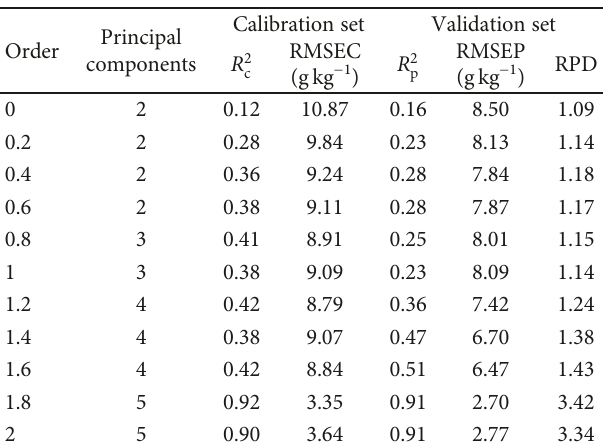
Table 2: Performance statistics of R model for calibration set and validation set based on PLSR.